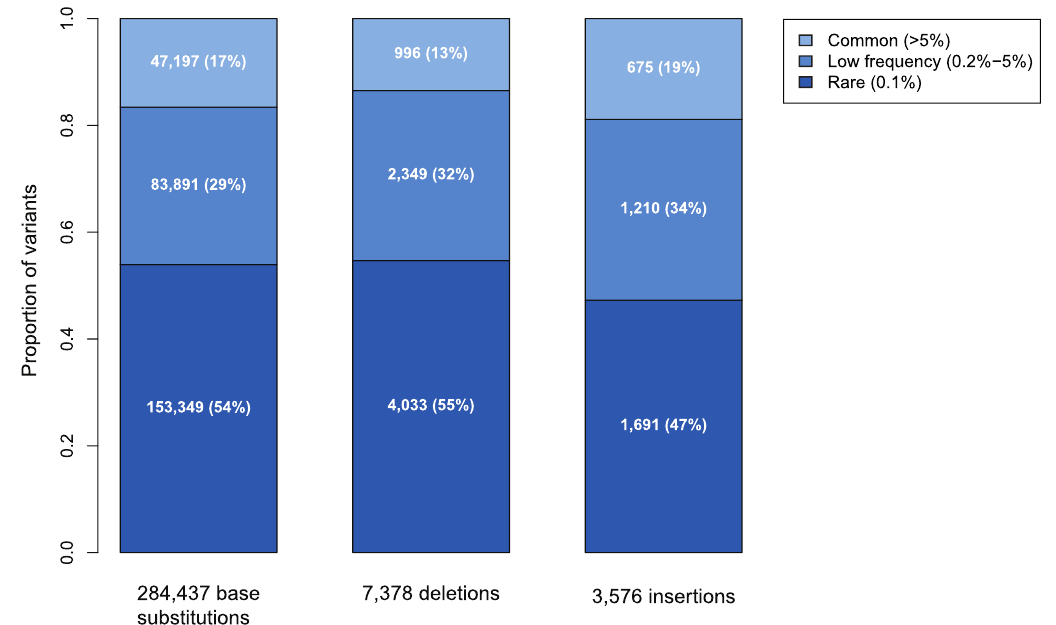
Figure 3. Summary of variants in the ICR1000 UK exome series by type and frequency. The number and percentage of variants in each category is shown in white text. For all variant types, rare variants predominate, and the distribution of variants of different frequencies is